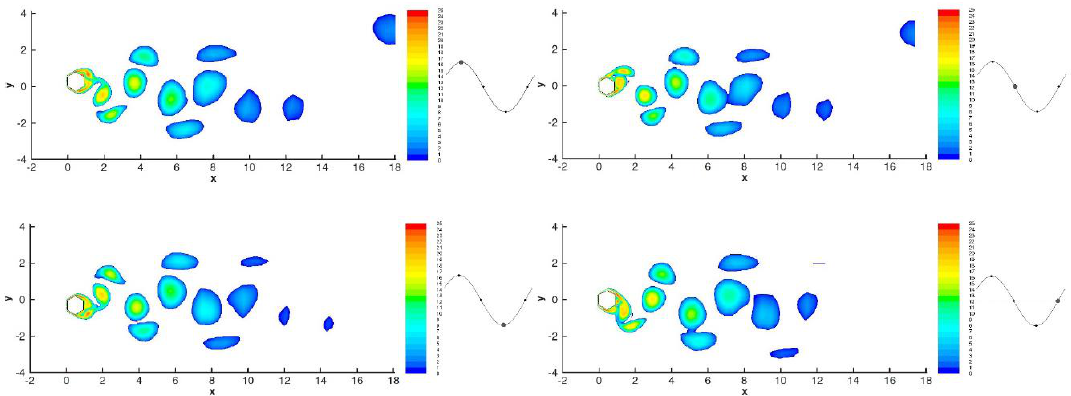
Figure 12. Vorticity contours at four instants in a vibration period of the face-oriented hexagonal cylinder at Vr = 18 at 4.70 < t* < 4.96.